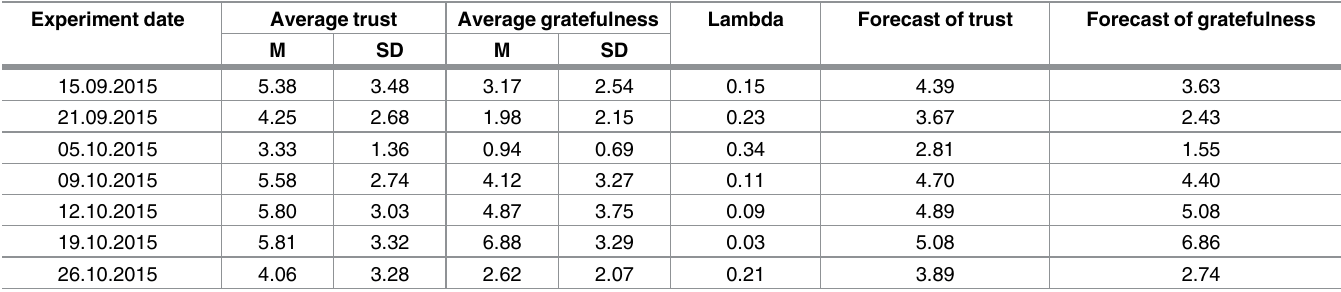
Table 4. Averagetrust and gratefulness in comparison with QRE for the